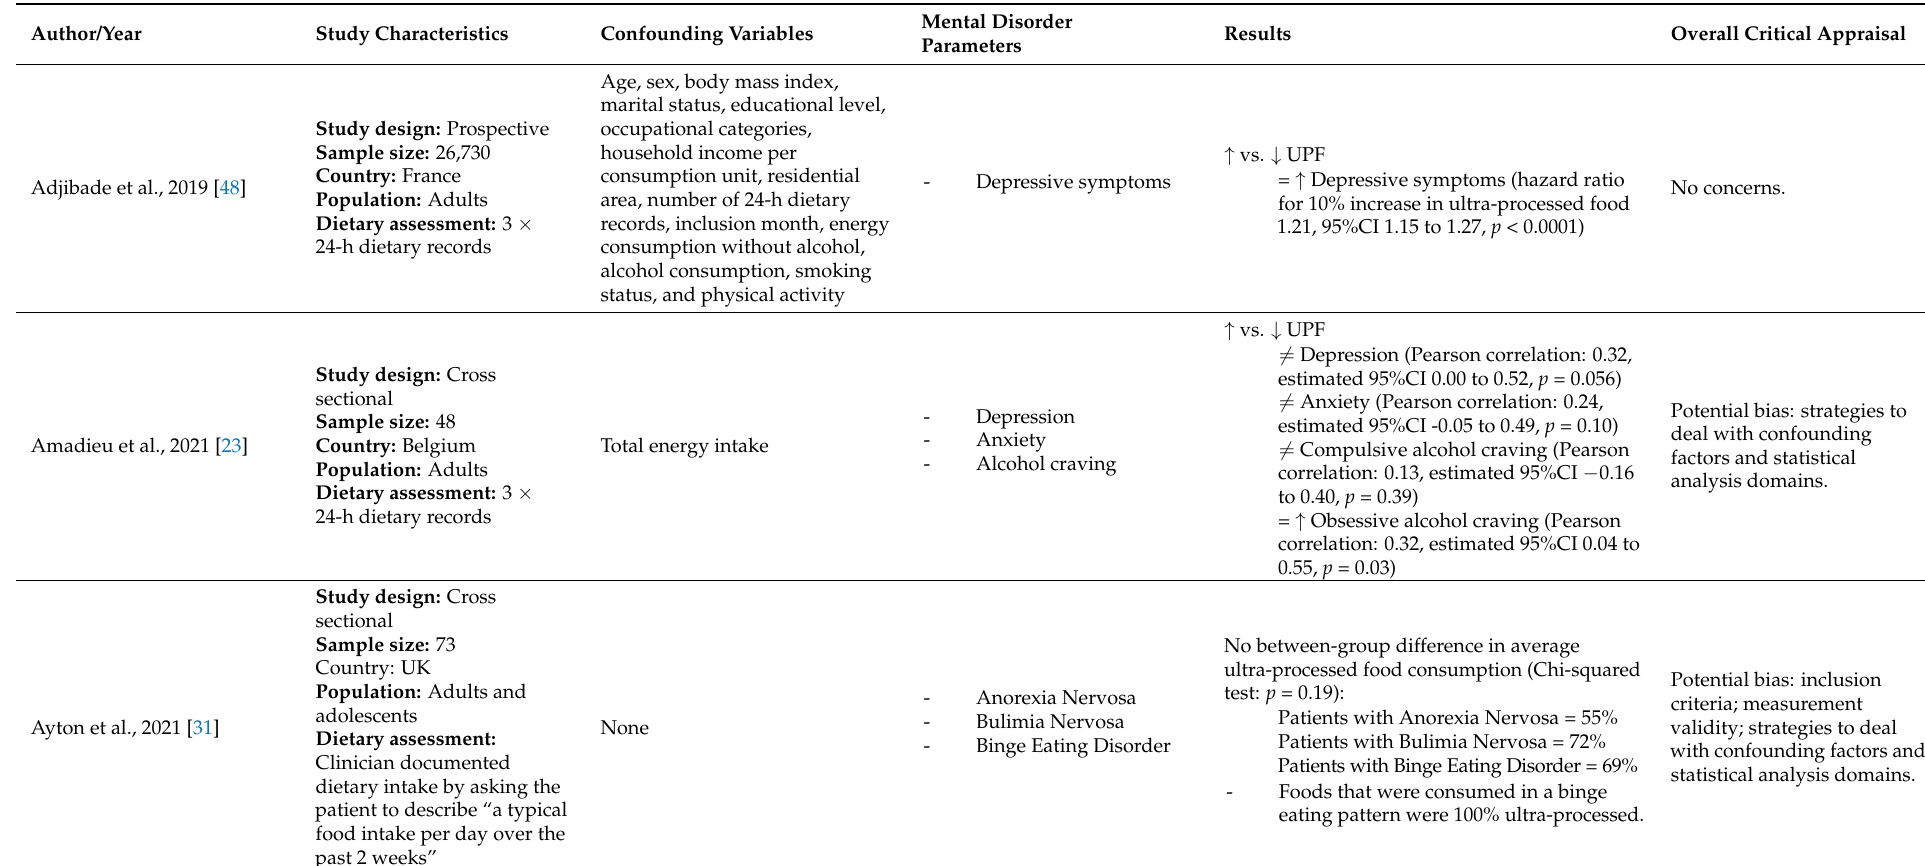
Table 1. Study characteristics and key